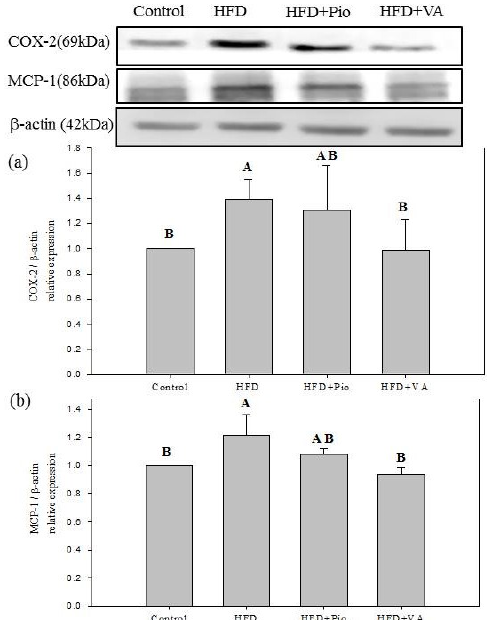
Figure 3. Hepatic ( a ) cyclooxygenase 2 (COX ‐ 2) and ( b ) monocyte chemoattractant protein ‐ 1 (MCP ‐ 1) protein expression in rats fed high ‐ fat diet for 16 weeks and orally administered with vanillic acid during the last 4 weeks. Control: normal diet; HFD: high ‐ fat diet (60 kcal % fat); HFD + Pio: HFD (60 kcal % fat) + pioglitazone (30 mg/kg body weight); HFD + VA: HFD (60 kcal % fat) + vanillic acid (30 mg/kg body weight); (A–C) indicate statistically significant differences p < 0.05. Data are presented as mean ± SD (3 rats in each group).